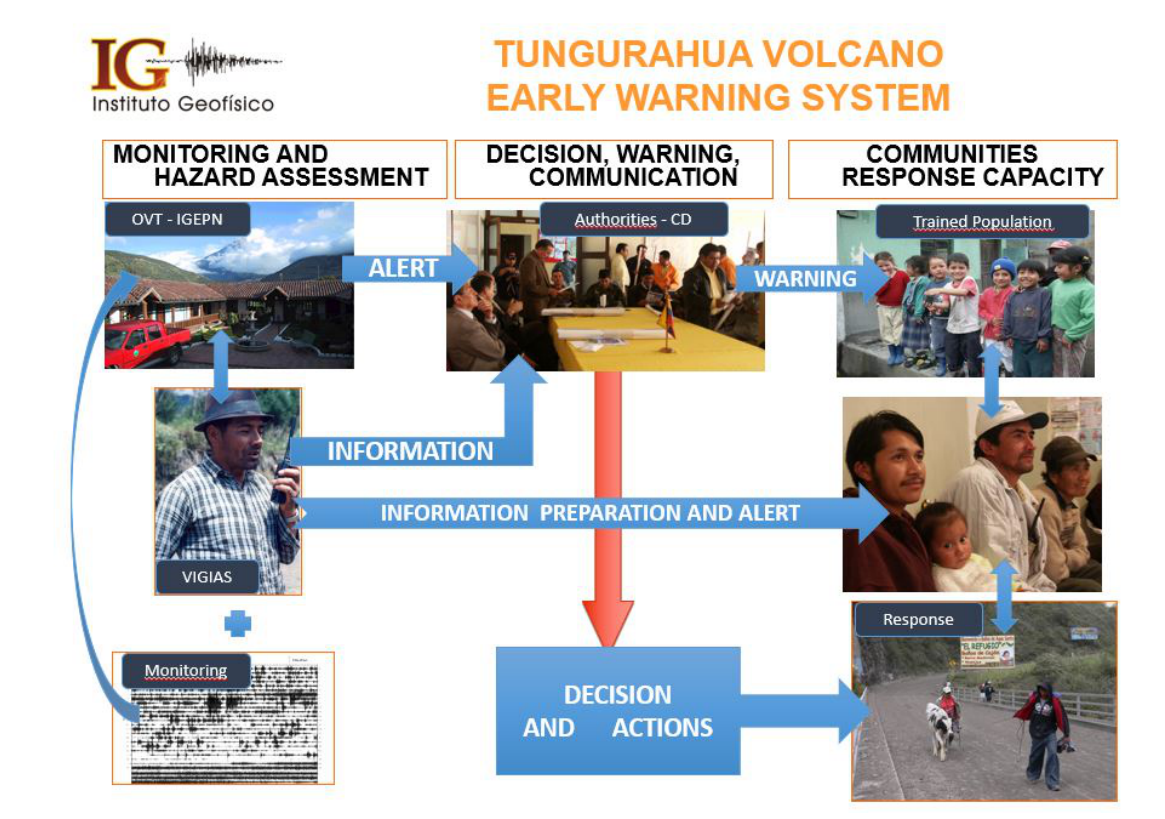
Figure 3: Early Warning System for Tungurahua eruption (1999–2016) [modified from Ramón